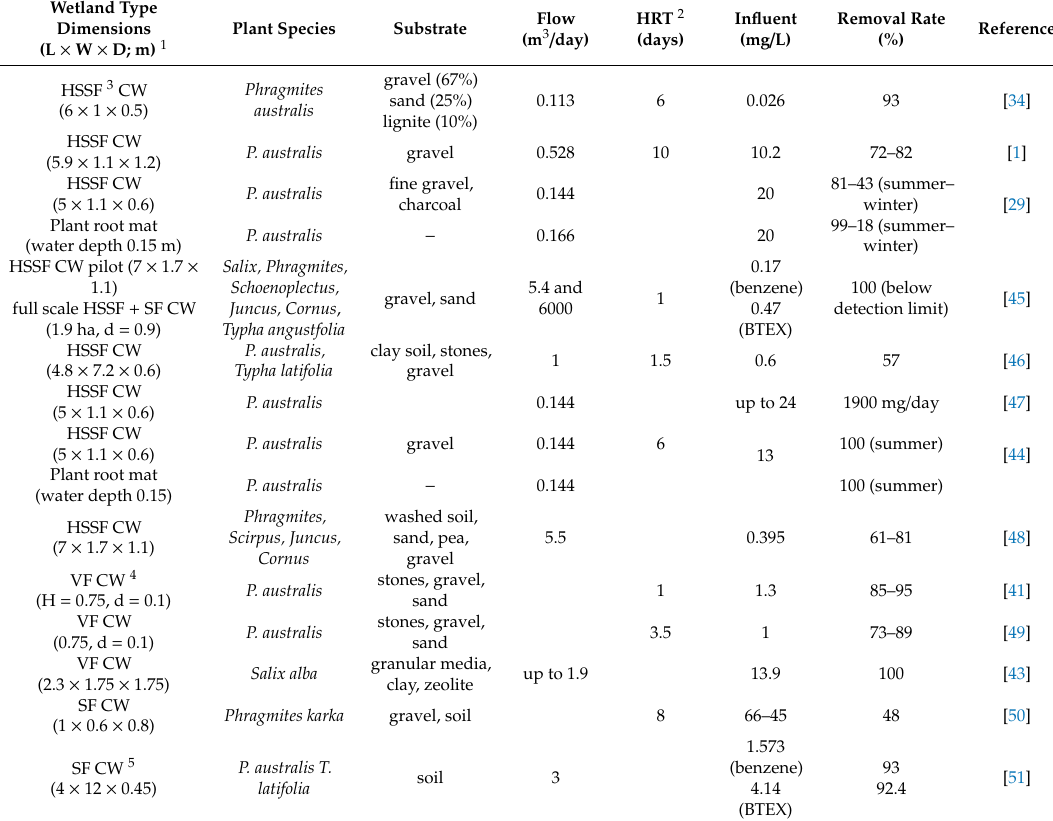
Table 1. Studies on constructed wetland (CW) systems treating water contaminated with